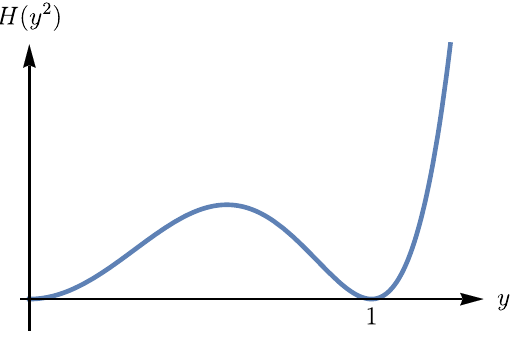
Figure 8 . The function H ( y 2 ) entering in (4.28), with two degenerate minima at y = 0 ;